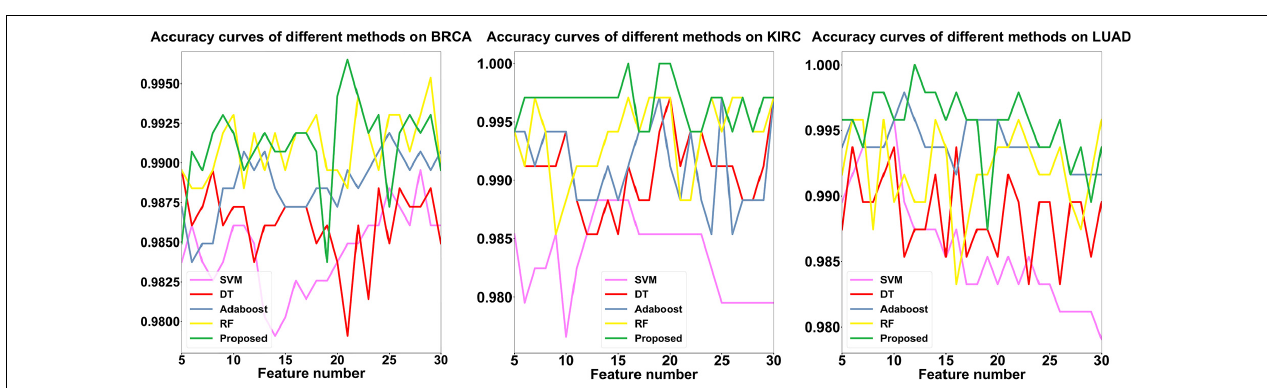
FIGURE 4 | The comparison results of different datasets. (A) The histogram of comparison results. (B) The annotated heatmap of comparison results. As is shown, compared with the other seven datasets, the integrated data of the protein-coding gene expression profiles, non-coding RNA expression profiles, and DNA methylation can improve the performance of the model.